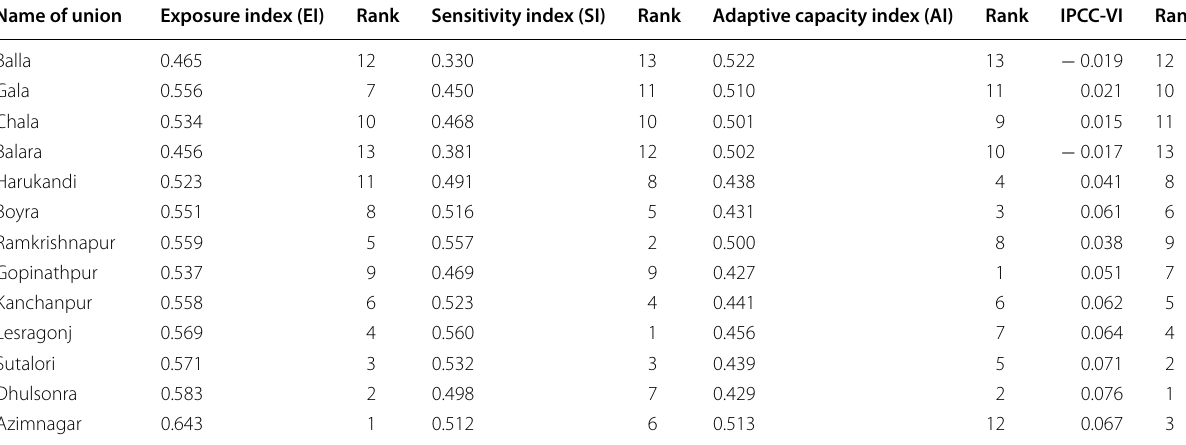
Table 7 Vulnerability index for different union of the study area